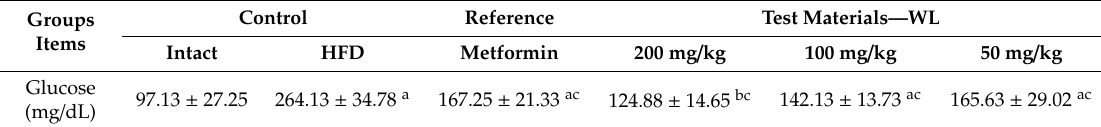
Table 5. Changes in blood glucose levels in NFD or HFD supplied mice.